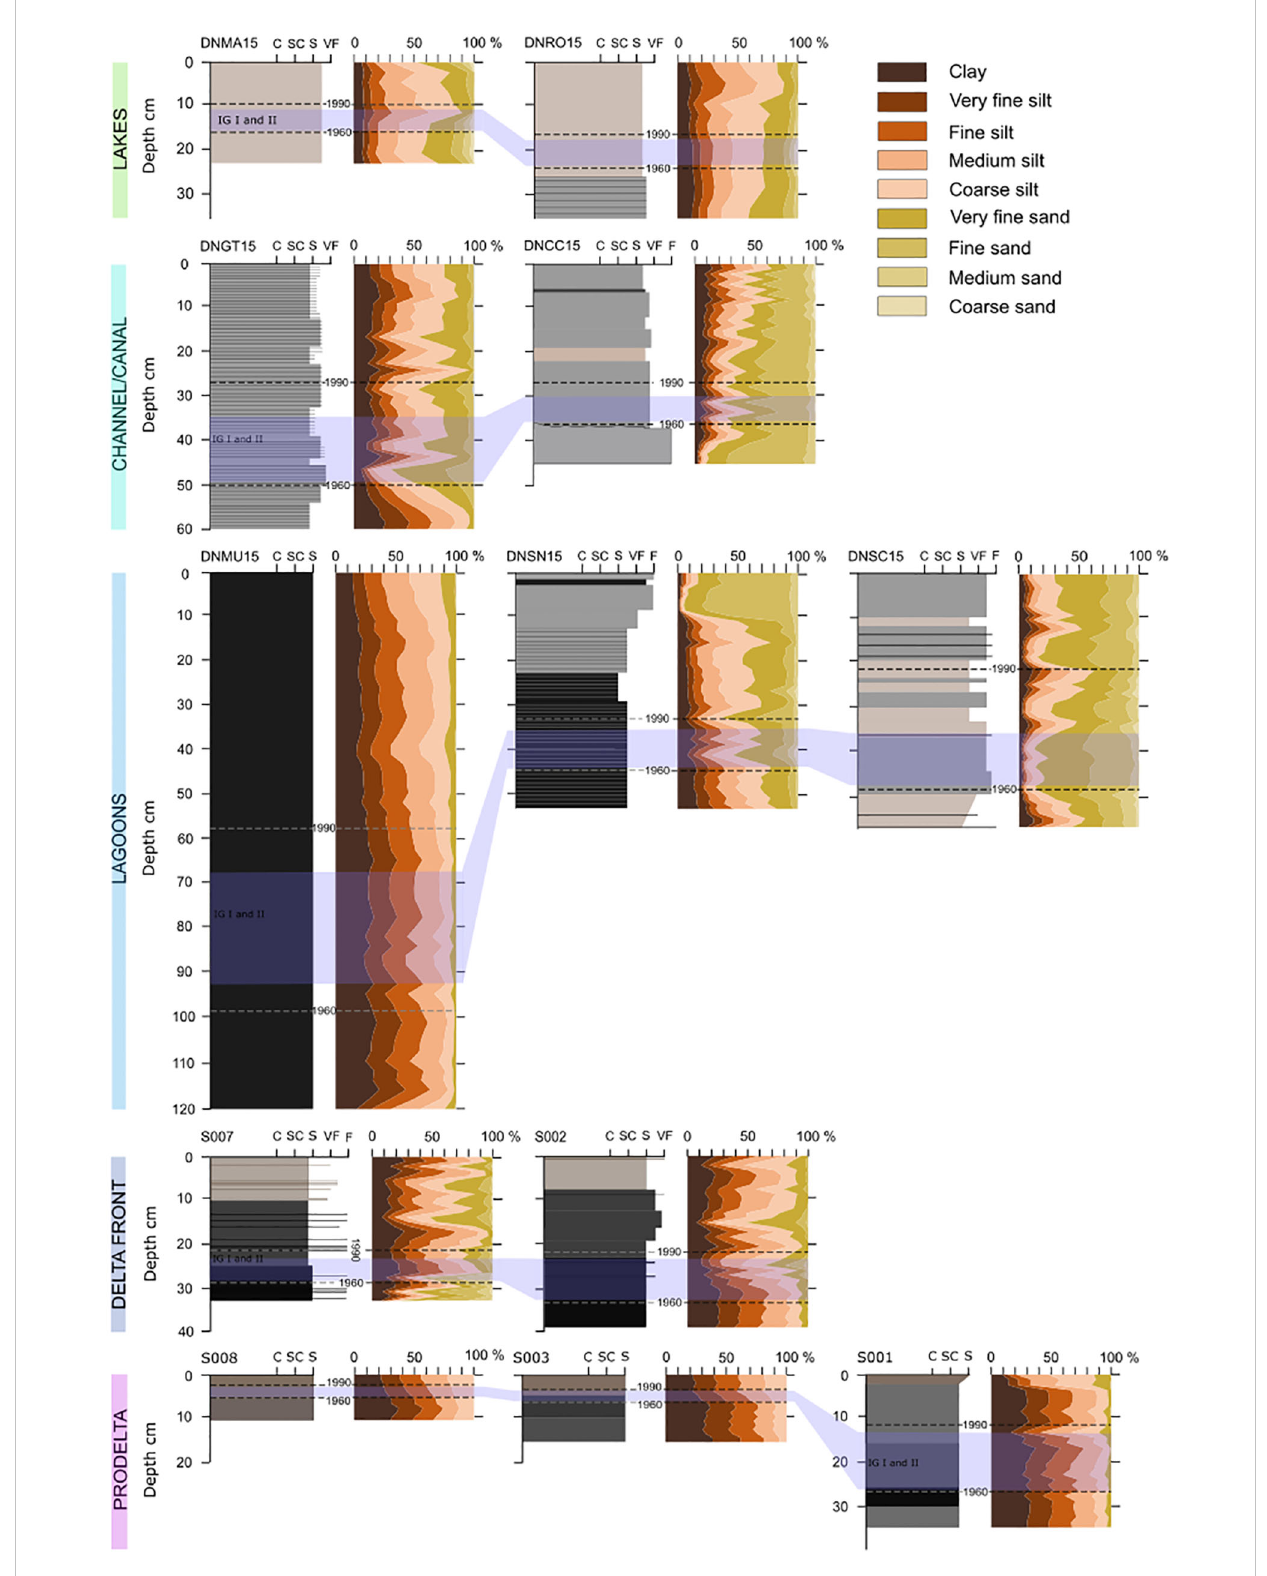
FIGURE 3 Sedimentary logs (real colour from visual descriptions) and grain size (in percentage of fractions) for the analysed cores from the Danube Delta, delta front and prodelta areas, showing the period of major anthropic interventions 1960-1990 (dotted lines) and the period of construction of Iron Gate I and II (1964-1984) (light purple